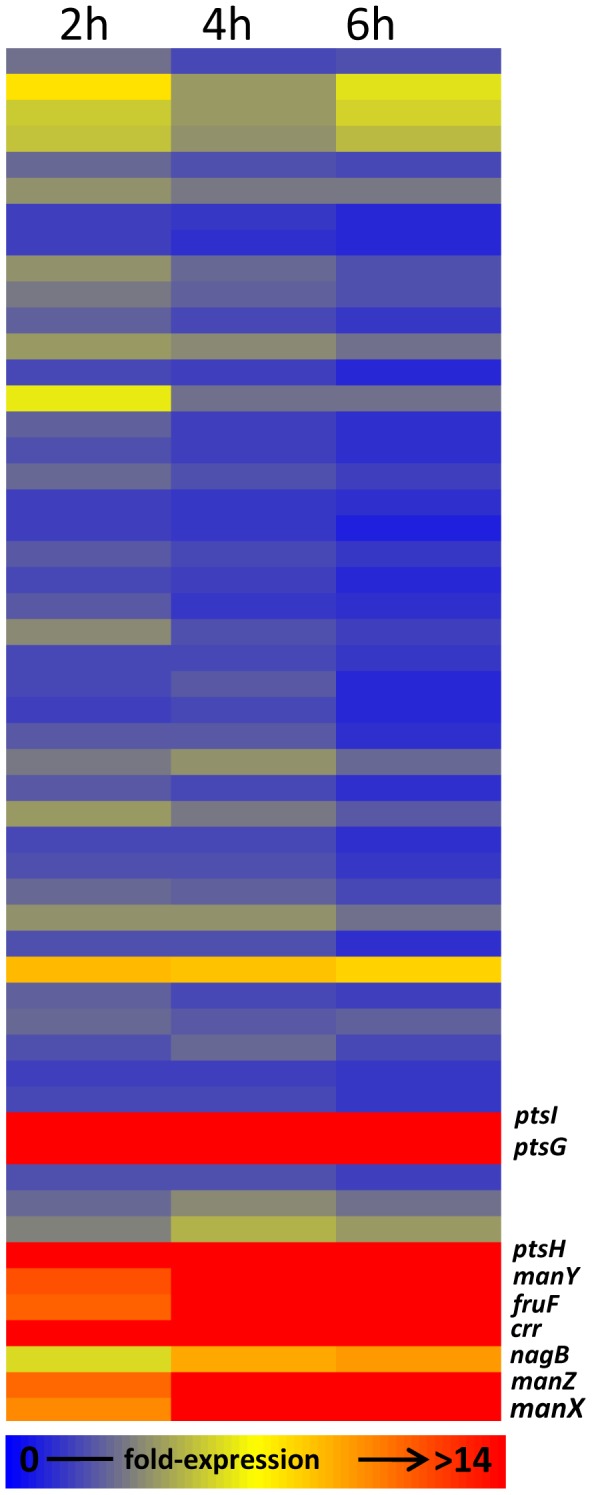
Hierarchical clustering of 53 S. Typhimurium PTS genes expressed during infection of HeLa cells.The filtered data was clustered according to similarity of expression level using the standard correlation tool in GeneSpring GX7.3™ (Agilent). Each gene is colour-coded according to the level of expression (i.e. signal ratio of cDNA versus genomic DNA). Highly expressed genes are shown in red and weakly expressed genes are dark blue. The clustering map was compiled from microarray data deposited at ArrayExpress (accession number E-MEXP-1368) and described in [16].